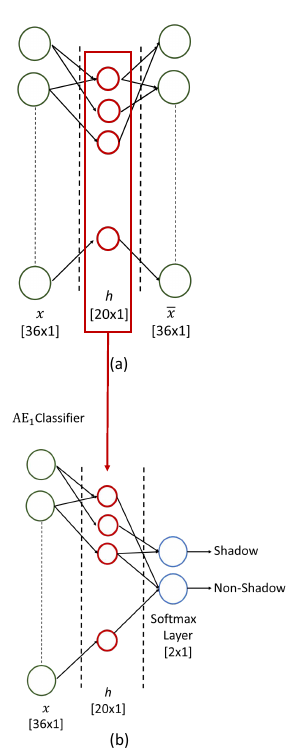
Figure 8. ( a ) Architecture of the autoencoder sized 36:20:36. ( b ) architecture of the AE 1